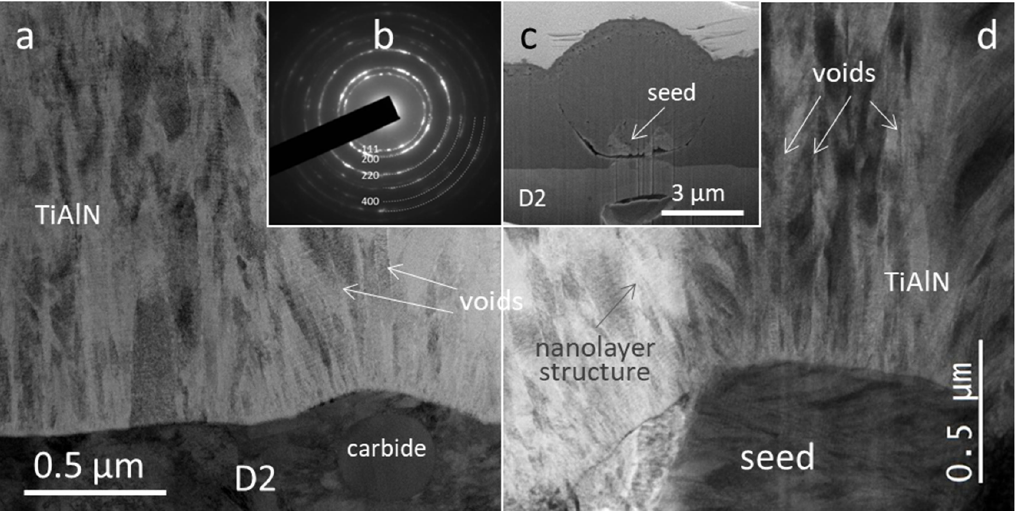
Figure 3. STEM image showing columnar morphology and nanolayer structure of sputter-deposited TiAlN coating outside ( a ) and inside the nodule defect ( d ). The corresponding electron diffraction patterns and SEM image of the FIB cross-section of the nodular defect are shown in insets ( b ) and ( c ), respectively. A step-like feature on the substrate surface under the seed particle (inset c ) indicates that the seed existed on the substrate surface already before ion etching.